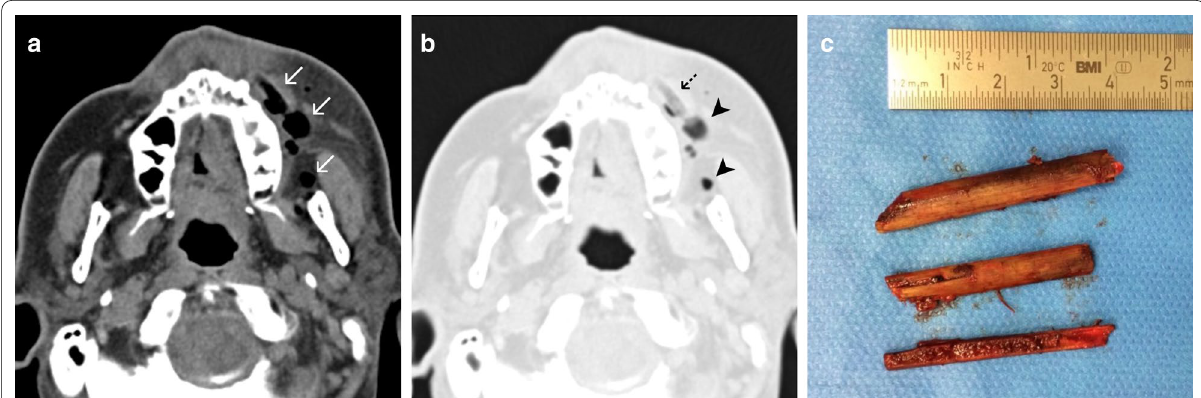
Fig. 1 Wooden stick. Axial CT image in soft tissue window ( a ) shows phlegmonous fat stranding in the left buccal region, surrounding multiple hypodense features (arrows), giving the impression of emphysema. Closer inspection of the lung windows ( b ) reveals that one of the hypodense structures has a discernible internal structure (dashed arrow), distinguishing it from the homogenously hypodense gas locules (arrowheads). Three pieces of a wooden stick were surgically removed ( c )